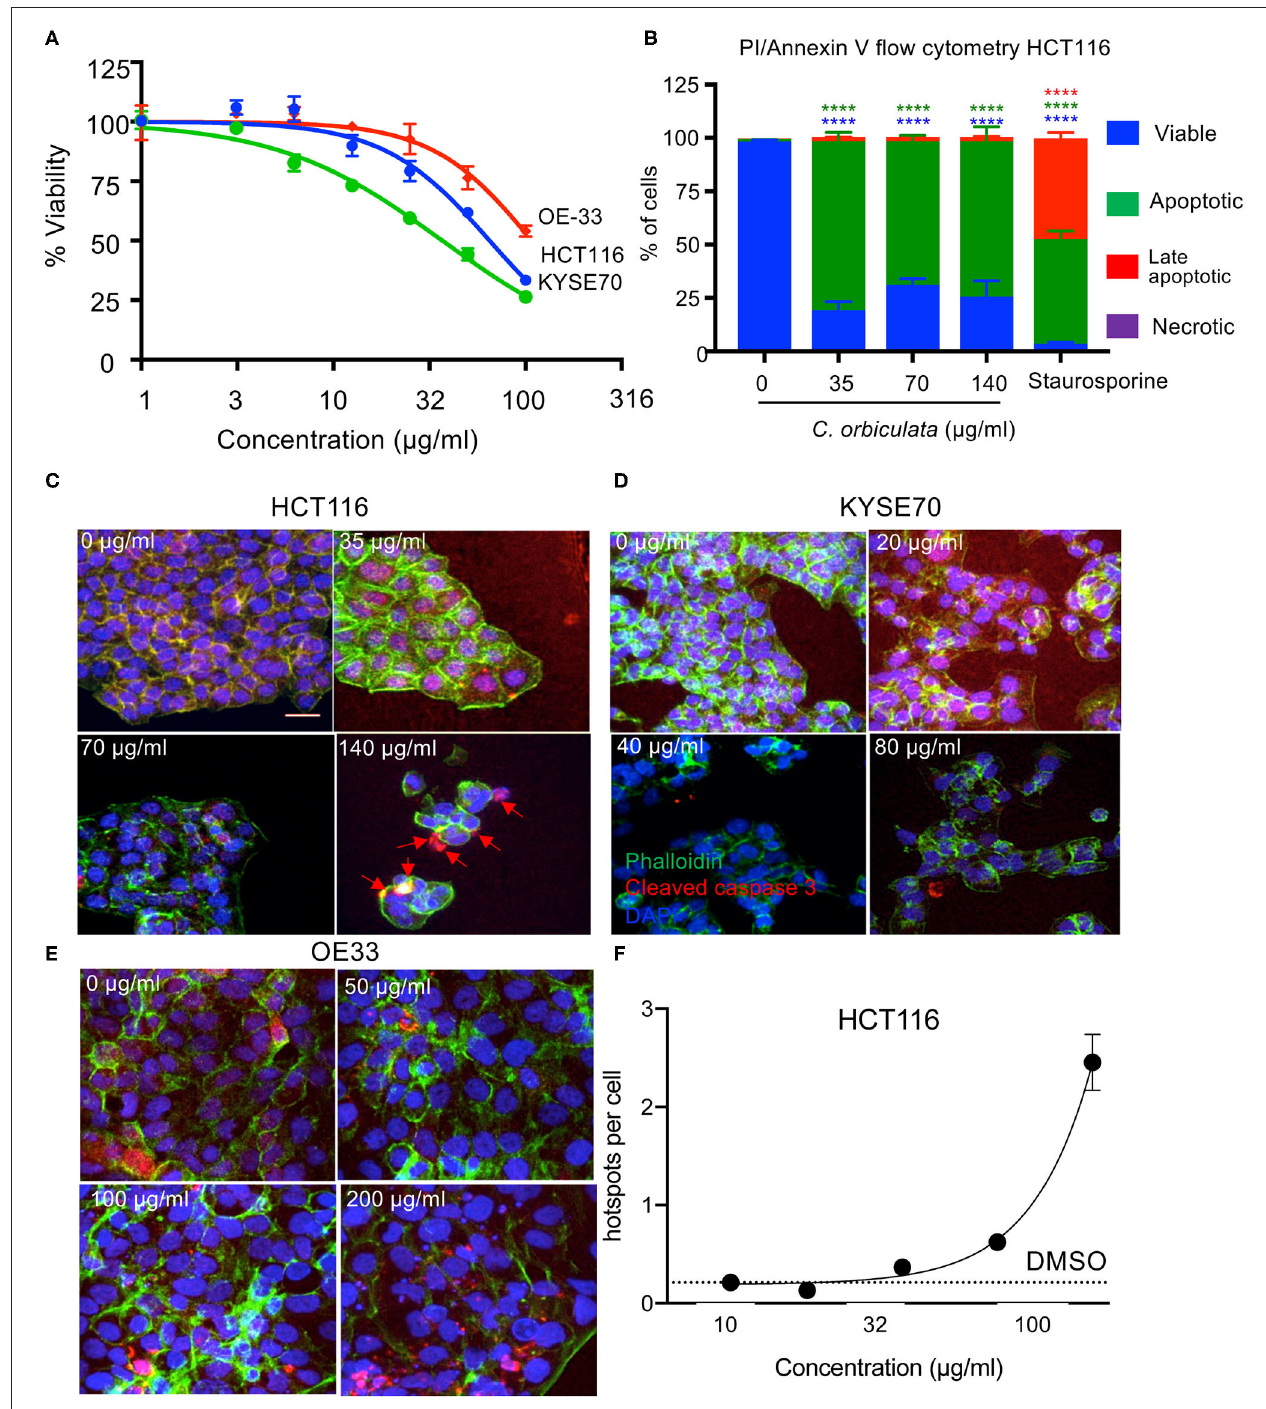
FIGURE 1 | Decreased cell proliferation in HCT116, OE33, and KYSE70 cancer cells treated with varying concentrations of C. orbiculata for 48 h. The extract reduces viability of all three cancer cells in a dose dependent manner. (A) Cell viability was determined using the WST-1 cell viability assay (mean ± SEM, n = 3). (B) Percent of HCT116 cells analyzed by flow cytometry positive for Annexin V and propidium Iodide (PI). (C) Immunocytochemical analysis for apoptosis induction in HCT116, (D) KYSE70, and (E) OE33 cancer cells treated with varying concentrations of the crude extract of C. orbiculata (calculated from LC 50 values) for cleaved caspase-3. Cells were fixed, permeabilised, and stained with DAPI (blue), phalloidin (green), and Caspase-3-cleavage antibody (red). There was an increase in cleaved caspase-3 per cell number in all three cell lines (e.g., red arrows); an indication of apoptosis induction. (F) Quantitative analysis of images shows a dose depended increase in cleaved caspase-3 in HCT116 cells. Results presented as caspase-3-cleavage/cell number, ± SEM (n = 3). Scale bar 25 µ m. One-way ANOVA, Dunnett’s multiple comparison test was used, * P < 0.05, ** P < 0.01, *** P < 0.001, **** P < 0.0001. See also Supplementary Figure 1 for quantitation of KYSE70 and OE33.